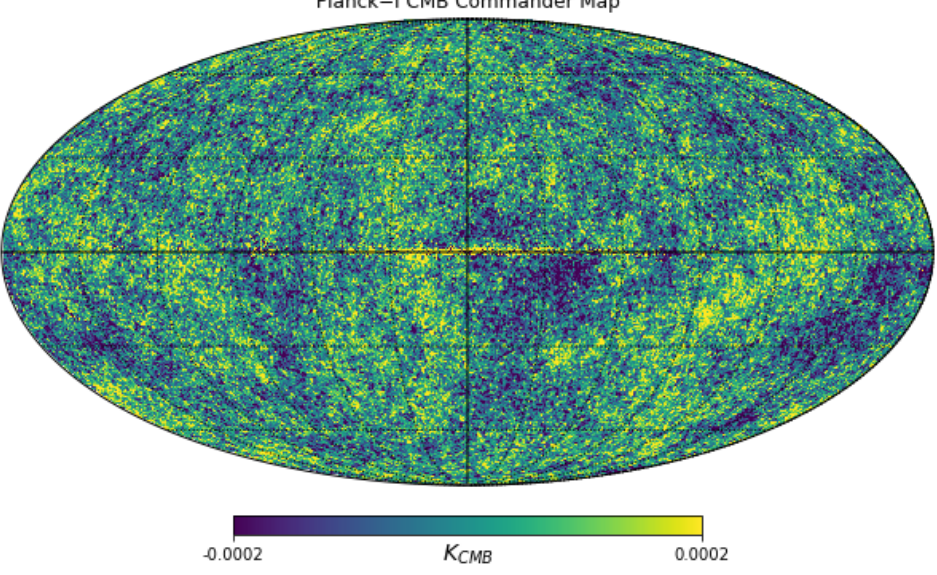
Figure 1. CMB anisotropies map obtained from the Planck satellite analyzed with the comman- der